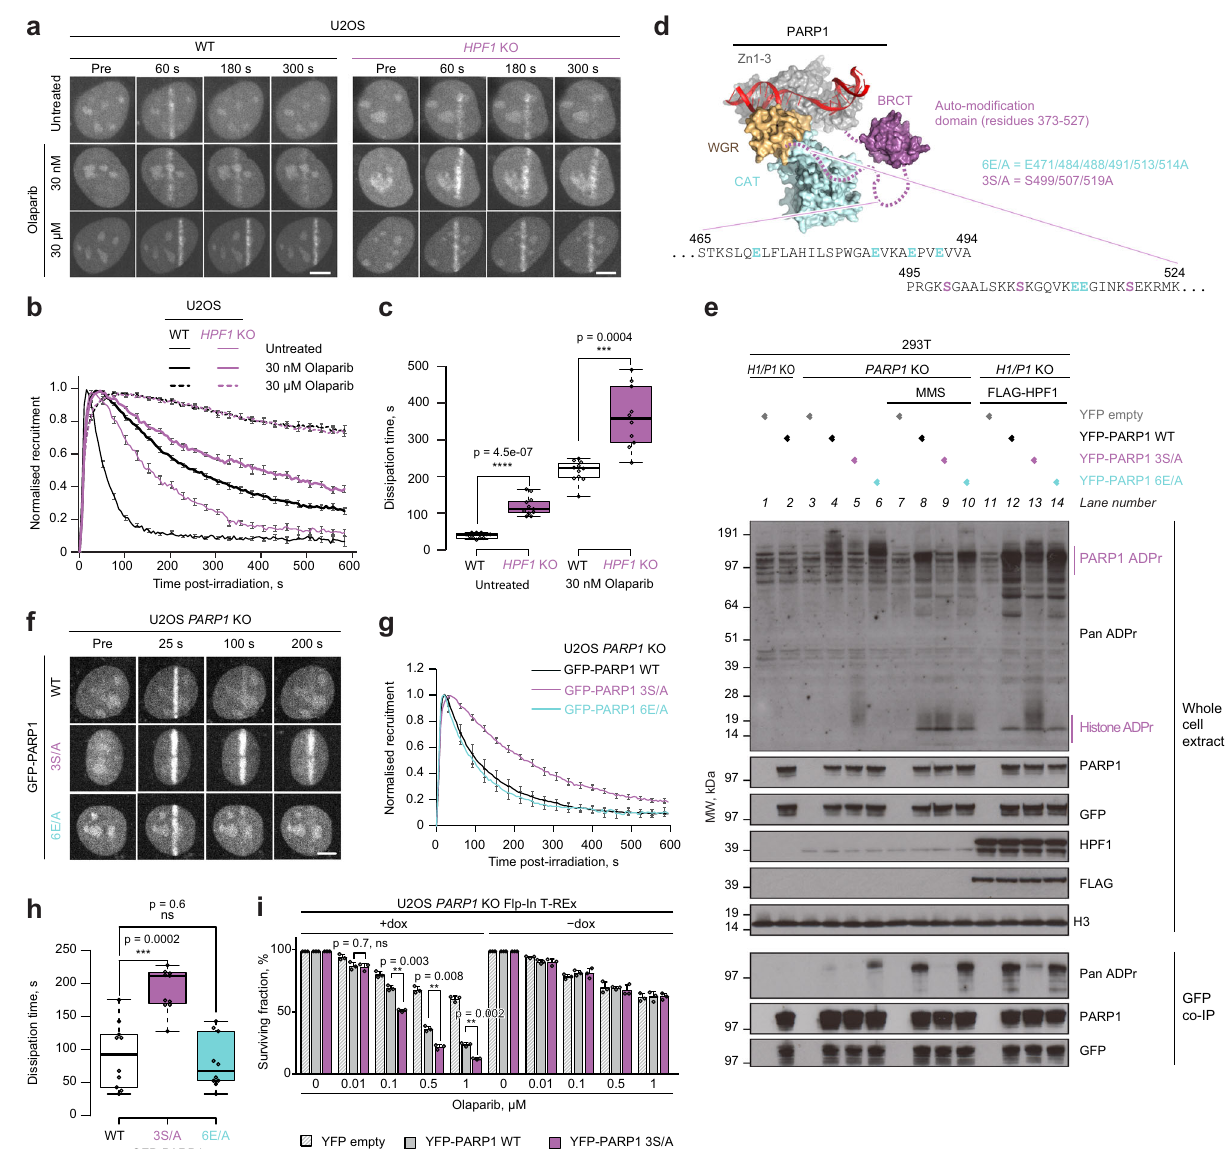
Fig. 3 PARP1 function and release from DNA damage depend on serine ADPr. a Representative confocal images of U2OS WT or HPF1 KO cells transiently expressing GFP-tagged PARP1 chromobody to follow endogenous PARP1 recruitment to sites of laser microirradiation over time in the presence of Olaparib. b Quanti fi cation of GFP-PARP1 chromobody accumulation kinetics at damaged sites in WT and HPF1 KO cells. A repeat of the experiment with additional concentrations of Olaparib is provided in Supplementary Fig. 5a. c Dissipation time of GFP-PARP1 chromobody, corresponding to the time required to dissipate 50% of the maximum PARP1 signal. d Model of PARP1 (surface representation coloured according to domain composition) bound to a single-strand DNA break (red ribbon) created by alignment of structures from PDB accessions 4DQY, 2N8A and 2LE0. The auto-modi fi cation fragment missing from the structures is shown schematically and its sequence containing ADPr sites mutated in point ( e ) is provided. e Mutation in key serine (S499/507/519A, 3S/A) but not glutamate PARP1 auto-modi fi cation sites (E471/484/488/491/513/514A, 6E/A) reduces the levels of endogenous and DNA damage (MMS)- or FLAG-HPF1 overexpression-induced PARP1 ADPr but increases the levels of histone ADPr. P1/H1 KO corresponds to PARP1/HPF1 KO cells. Representative immunoblots of whole-cell extracts and GFP coimmunoprecipitation (GFP co-IP) samples from three independent experiments are shown. f Representative confocal images of GFP-PARP1 WT, 3S/A or 6E/A recruitment to sites of laser microirradiation over time. g Quanti fi cation of the accumulation kinetics of GFP-PARP1 WT, 3S/A or 6E/A at damaged sites. h Dissipation time of GFP-PARP1 WT, 3S/A or 6E/A. i Loss of key serine auto- modi fi cation sites in PARP1 3S/A mutant leads to increased cell sensitivity to Olaparib. Data are shown as mean ± SEM of three independent experiments. See Supplementary Fig. 7b for GFP, PARP1 and H3 control immunoblots. In ( a ) and ( f ), the scale bar represents 5 μ m. In ( b ) and ( g ), individual curves were normalised to maximum recruitment; data are shown as mean ± SEM from the analysis of at least 10 nuclei. In ( c ) and ( h ), the box limits correspond to the 25th and 75th percentiles and the bold line indicates the median value; the whiskers extend 1.5 times the interquartile range. * p < 0.05; ** p < 0.01; *** p < 0.001 (two-tailed Student ’ s t -test). Experiments shown in ( a , e , f ) were repeated independently at least 3 times with similar